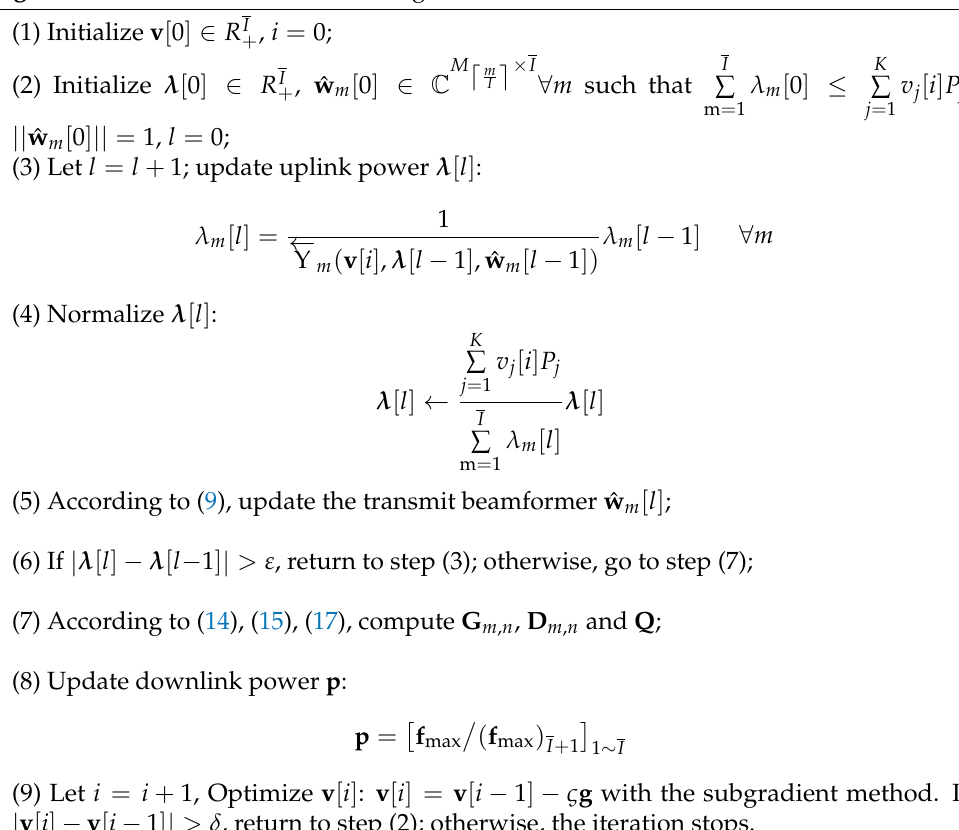
Algorithm 1 Coordinated Beamforming for